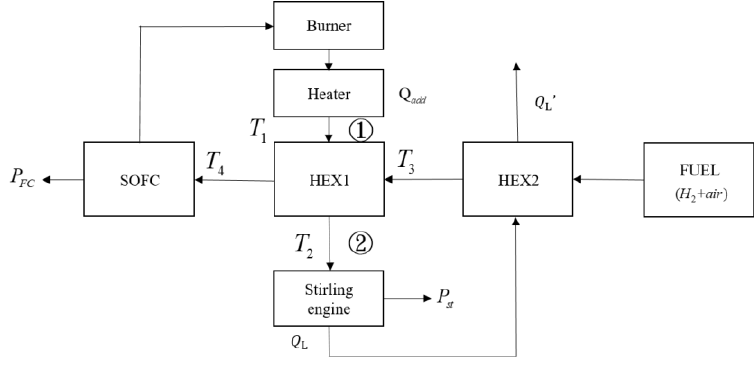
Figure 2. Schematic diagram of the hybrid SOFC–SE system.